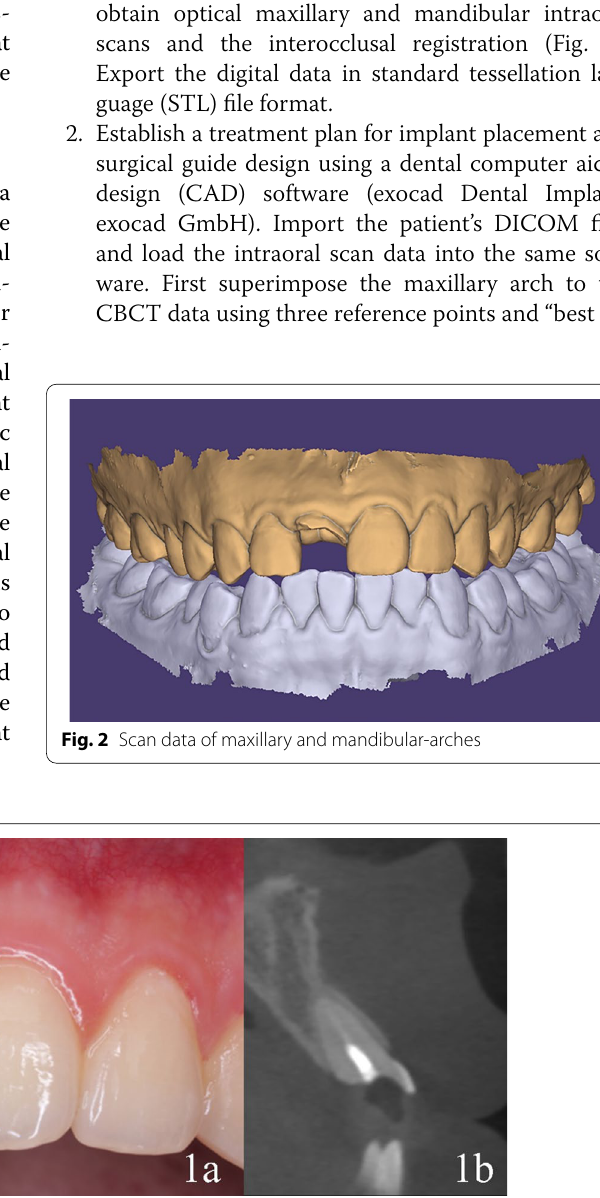
Fig. 1 Preoperative situation. a Frontal view of the upper right central incisor. b CBCT scan of the upper right central incisor area, cone beam computed tomography